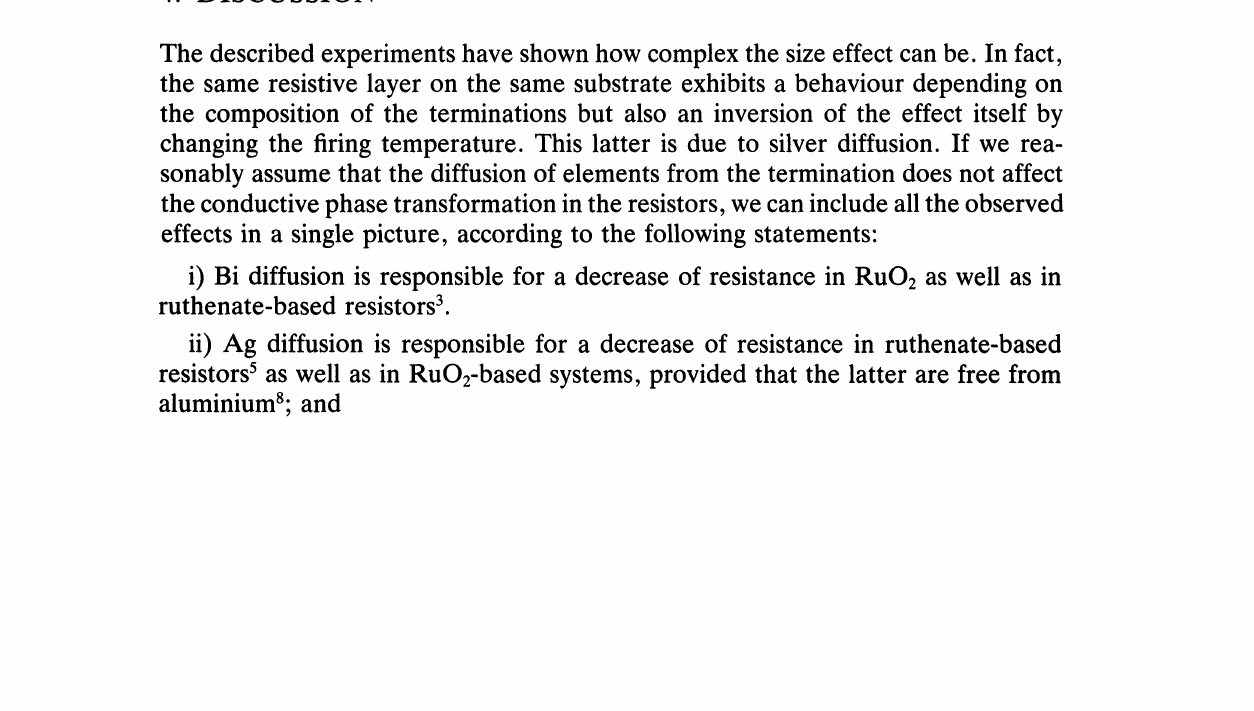
FIGURE 5 Variation of Normalised Sheet Resistance with Resistor length for the resistor terminated with 9596 and fired at different peak